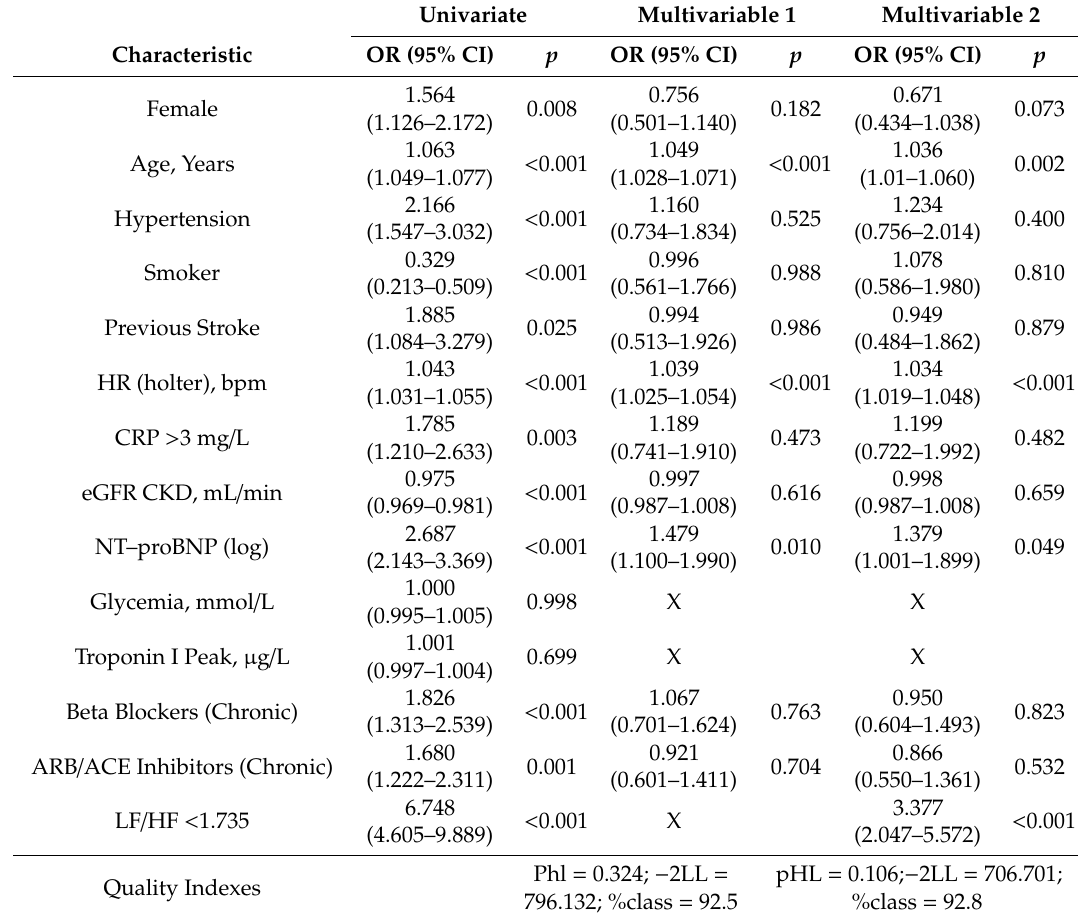
Table 5. Logistic regression analysis for the prediction of in-hospital